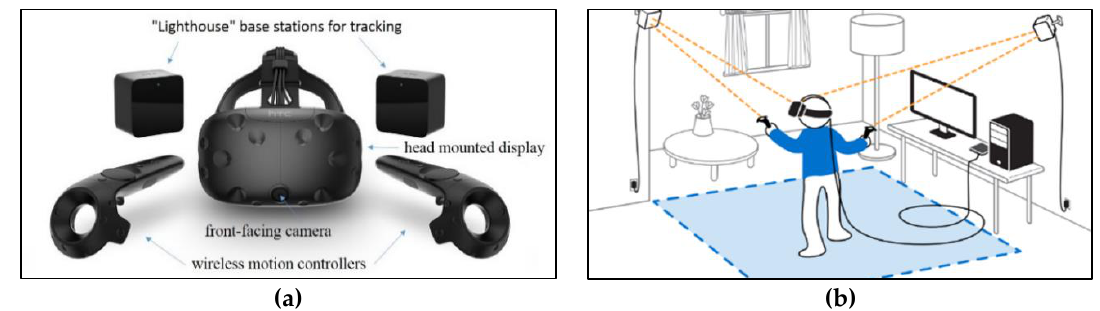
Figure 4. Components ( a ) and schematic setup ( b ) of the VR system HTC Vive with interaction area (blue) [29].